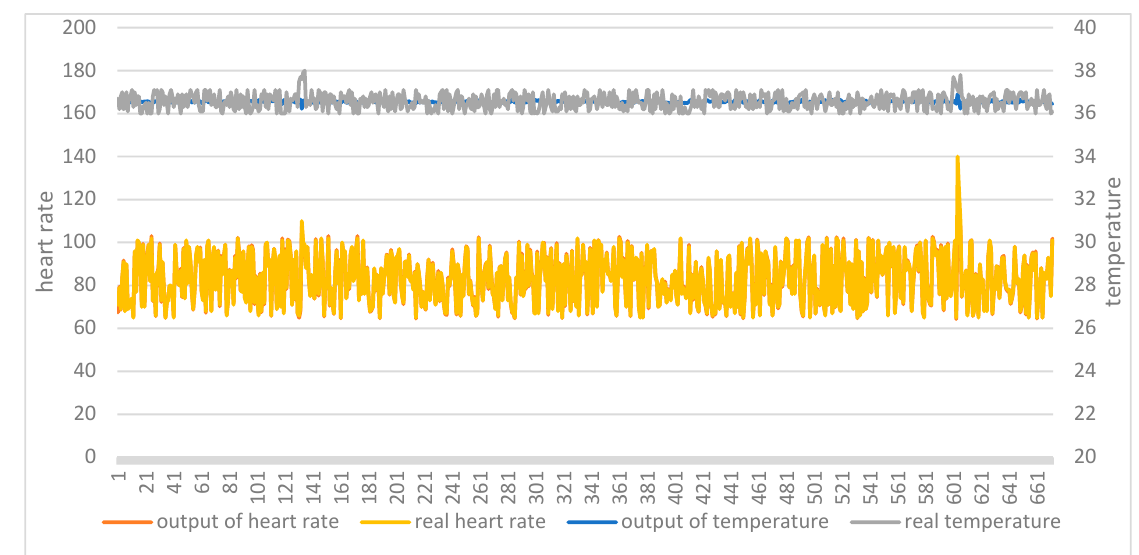
Figure 13. Comparison of input and output of AutoEncoder model in test set 2.